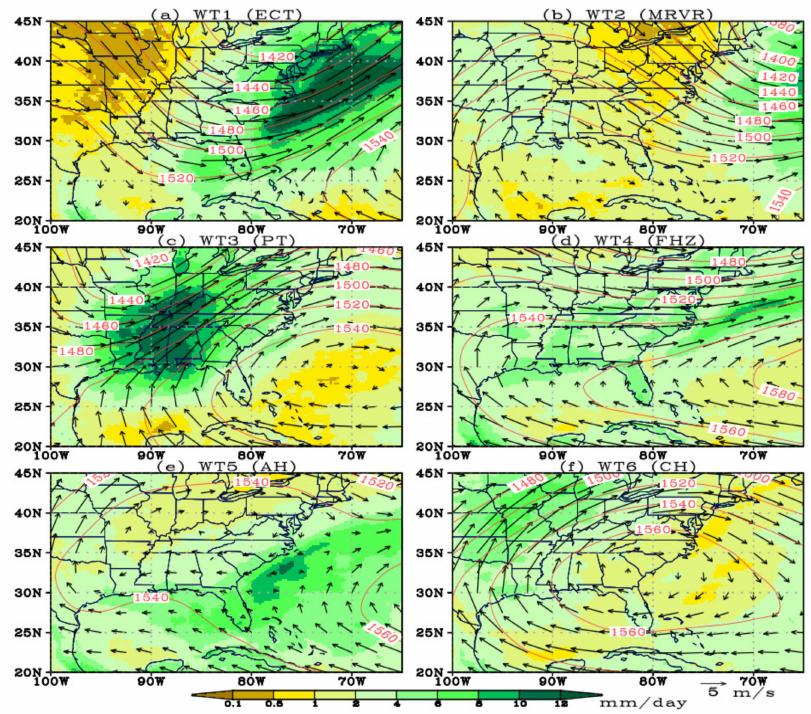
Figure 3. The average precipitation (shade), 850 hPa winds (arrows) and geopotential height (red contours) of the six WTs. WTs 1–6 (shown in subfigures ( a – f ), respectively) can be briefly described as East Coast Trough (ECT), Mississippi River Valley Ridge (MRVR), Plains Trough (PT), Florida High Zone (FHZ), Appalachian High (AH), and Carolina High (CH), respectively.